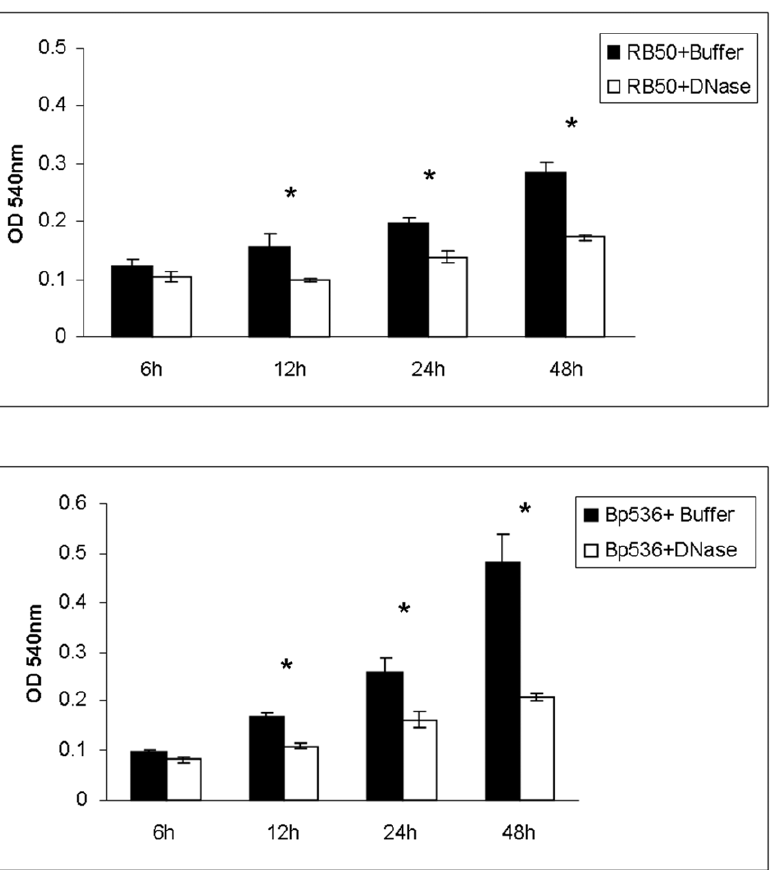
Figure 2. DNase I inhibits Bordetella biofilm formation. The indicated strains were grown in 96 well microtitre plates for RB50 or 12 well plates for Bp536 for designated time points in SS medium supplemented with either DNase I resuspended in the reaction buffer or the reaction buffer alone. Wells were rinsed and stained with crystal violet followed by quantification of bound crystal violet as described in Materials and Methods. Each data point is the average of six wells, and error bars indicate the standard deviation. Representative data from one of at least three independent experiments are shown. Asterisks designate a value of P , 0.05 (students t -test).